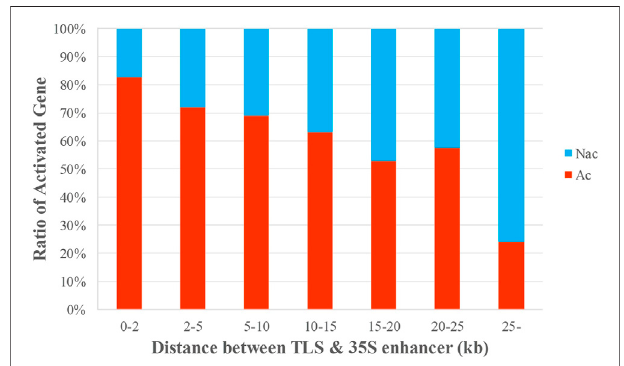
FIGURE 2 | Correlation between distance and gene activation. The data were sorted by the distance between the 35S enhancer and the TLS, and the ratio of Ac to NAc genes in each group was calculated. The x -axis is the distance from the 35Senhancer to the TLS ofa target gene; the y -axis is the proportion of Ac and NAc genes in each